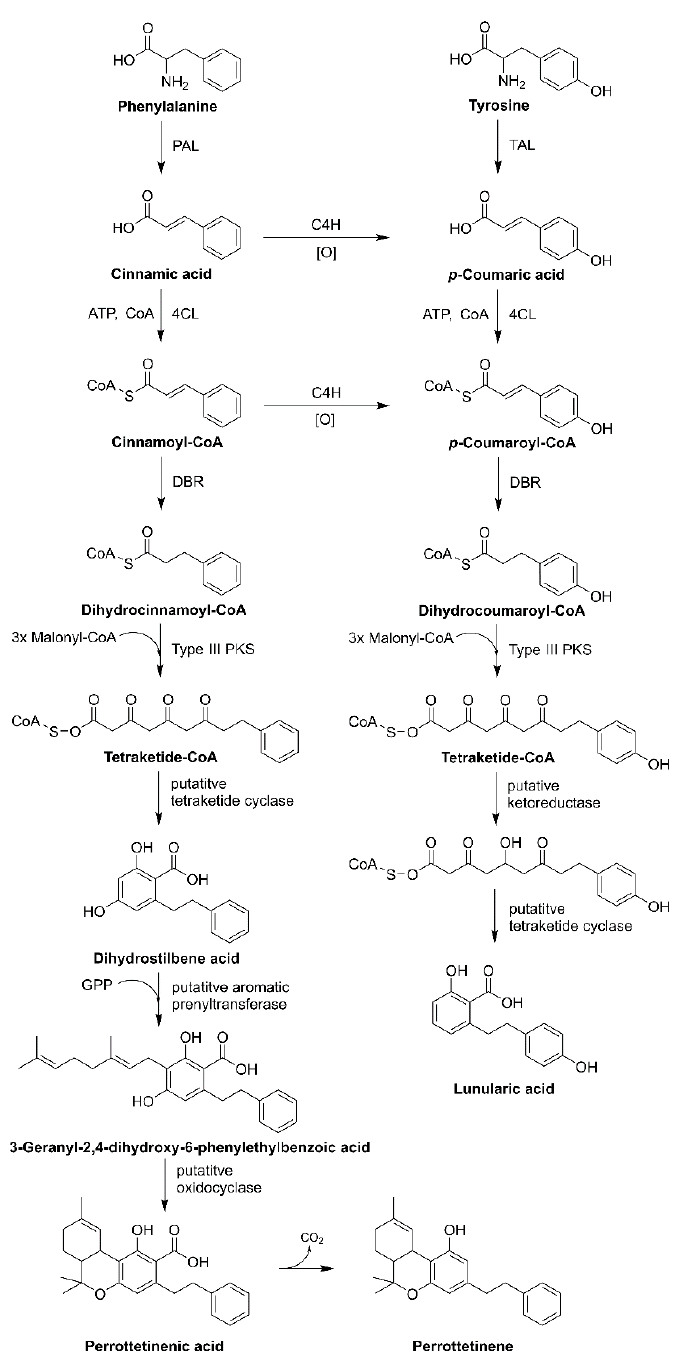
Figure 7. Phytocannabinoids biosynthesis in liverworts. Abbreviations: C4H, cinnamate 4-hydroxylase; 4CL, 4-coumarate:CoA ligase; PAL, phenylalanine ammonia-lyase; TAL, tyrosine ammonia-lyase.